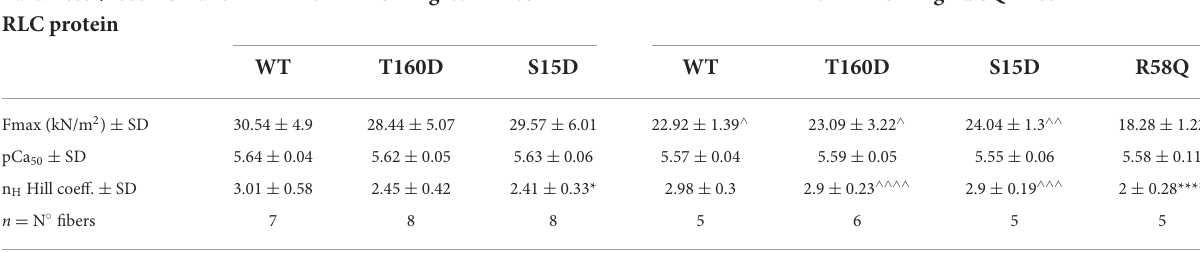
TABLE 3 Contractile function in skinned LVPM from Tg-WT and Tg-R58Q mice reconstituted with recombinant RLCs proteins. Parameter/recombinant